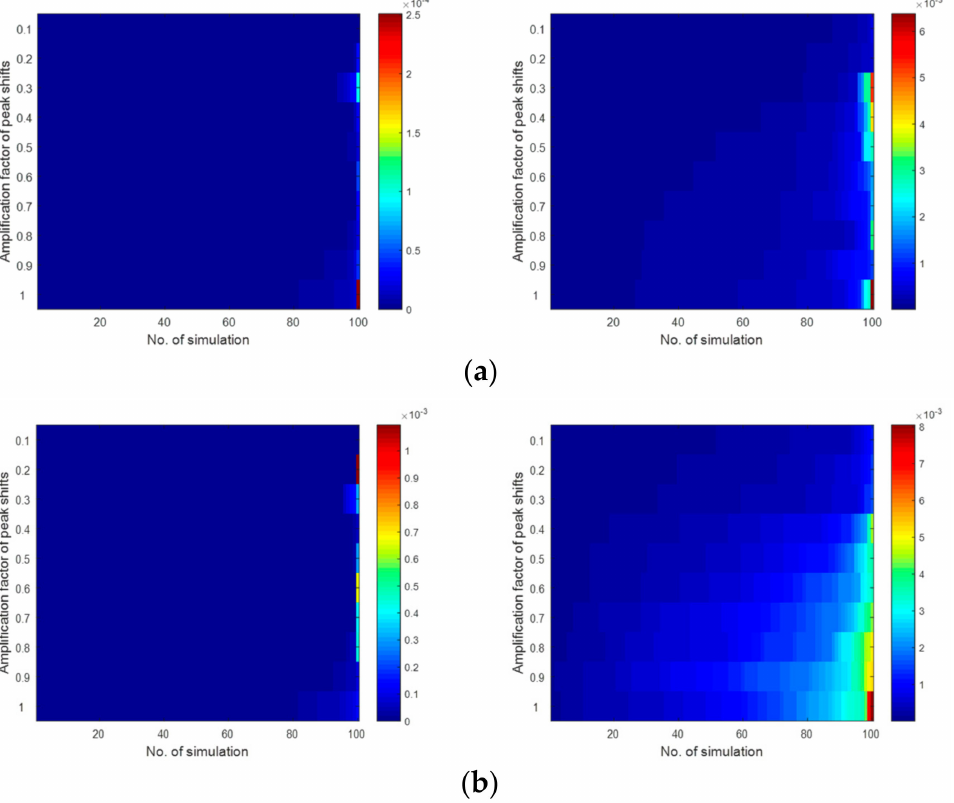
Figure 8. Color maps presenting sorted results of simulation study taking into account gradually increasing peak shifts in signals for two different templates of warping functions, respectively: ( a ) absolute differences computed between coordinates of the corresponding samples described by second-order signals and their variant with peak shifts induced by two different templates of warping functions, ( b ) absolute differences computed between the percentage of explained data variance by corresponding principal components obtained from the Gram PCA approach for original and transformed data using two different templates of warping